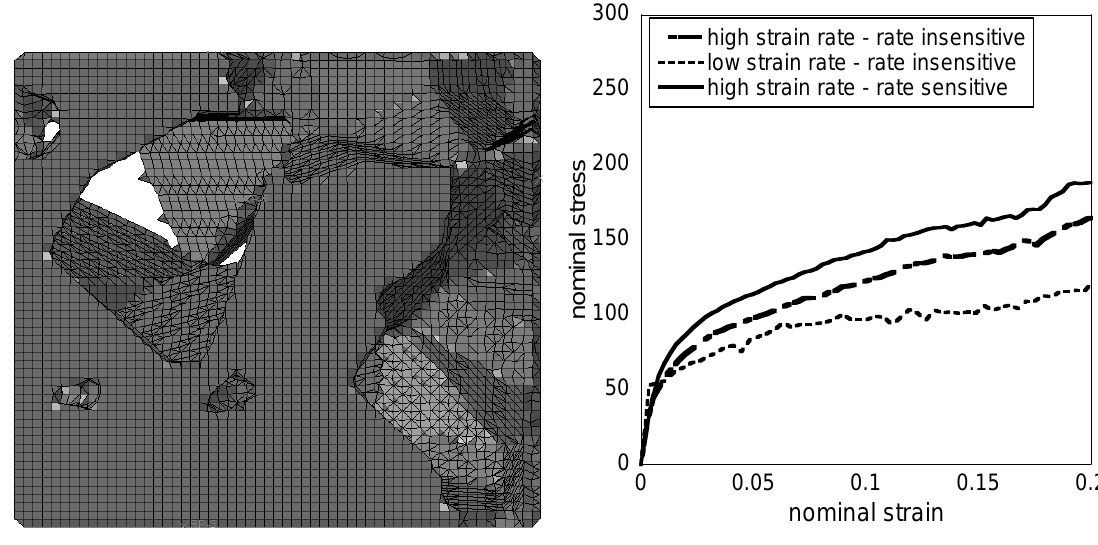
Figure 5. ( Left ) mesh of a virtual foam of relative density 0.36  ; ( Right ) FE predictions of the macroscopic material